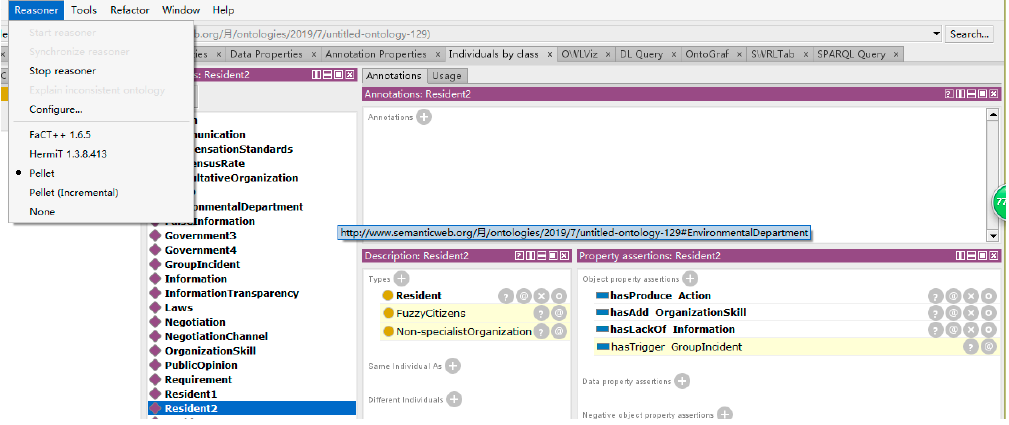
Figure 10. The inference result of individual in Protégé.